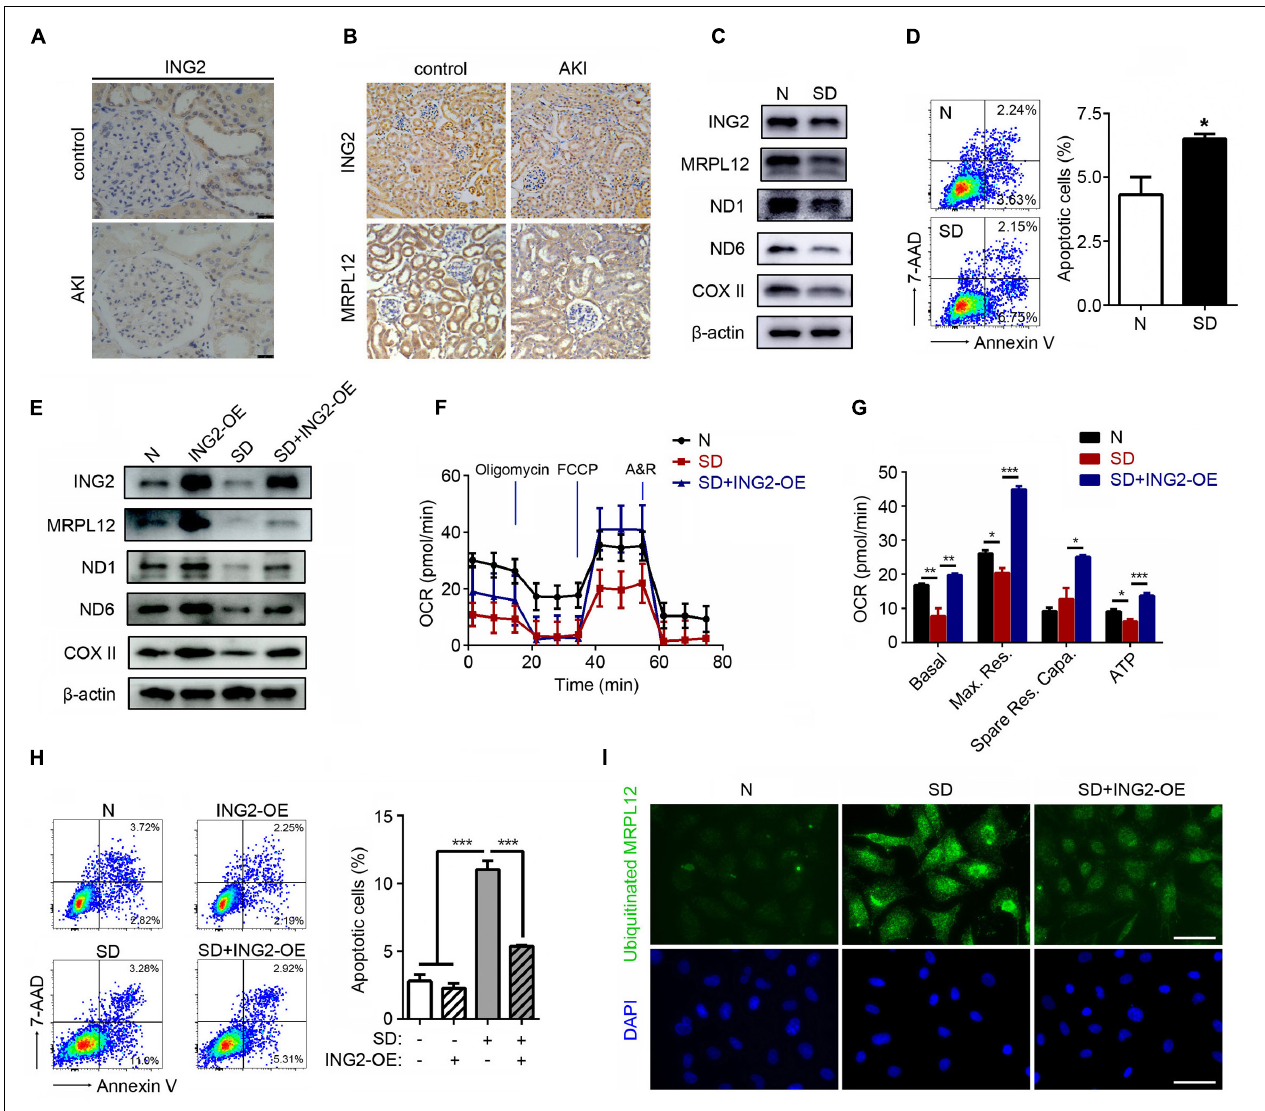
FIGURE 4 | ING2 ameliorated the ischemia induced mitochondrial OXPHOS defects and tubular cell apoptosis. (A) Immunostaining of kidney tissue section from healthy individual and AKI patients with antibodies against ING2. At least two patients for each. (B) Immunostaining of kidney tissue section from healthy and AKI mice with antibodies against ING2 and MRPL12. HK2 cells were subjected to serum deprivation for 48 h, and protein contents of both ING2, MRPL12, and mtDNA-encoded components of mitochondria complex (C) were figured out by Western blotting. The apoptosis of HK2 cells was evaluated by flow cytometry (D) . HK2 cells were divided into control group, ING2 overexpression group, serum deprivation group, and serum deprivation plus ING2 overexpression group. MRPL12 and mtDNA-encoded components of mitochondria complex were detected through Western blotting (E) . Mitochondrial OXPHOS was detected using Seahorse (F,G) . The apoptosis of HK2 cells was evaluated by flow cytometry (H) , and the ubiquitination of MRPL12 was determined by proximity ligation assay (PLA) (I) . OCR, oxygen consumption rate; FCCP, carbonyl cyanide 4-(trifluoromethoxy)phenylhydrazone; A&R, antimycin and rotenone. Data were from three individual experiments and presented as mean ± SEM. * p < 0.05, ** p < 0.01, *** p < 0.001. ns, not